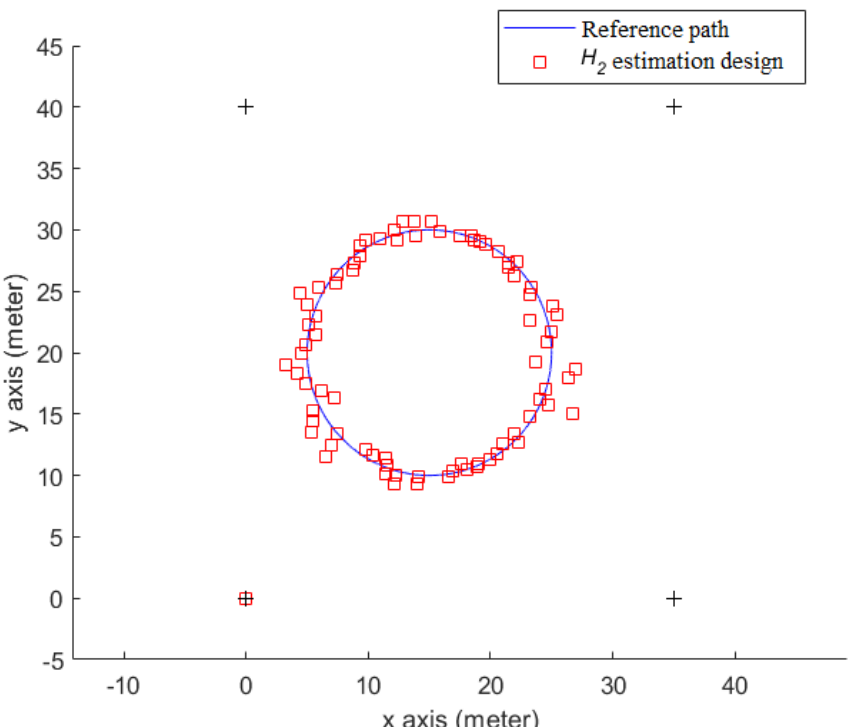
Figure 9. The indoor positioning result of the proposed H 2 estimation design (simulation).